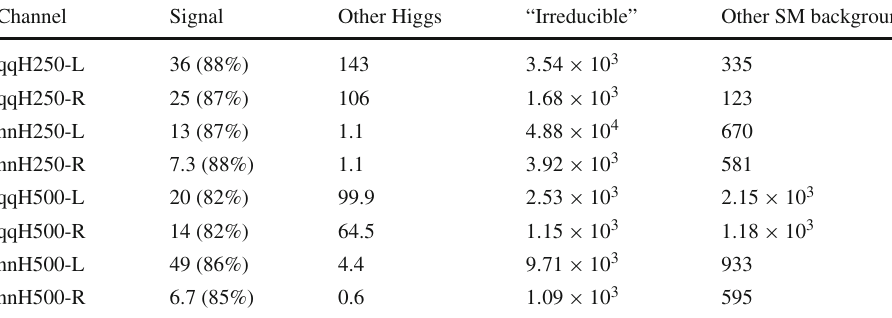
Table 7 The number of signal and background events in each channel after the channel-specific cuts, weighted to the beam polarisation and luminosity settings given in Table 1. The definition of “irreducible” is in the text. Numbers in brackets show the signal selection